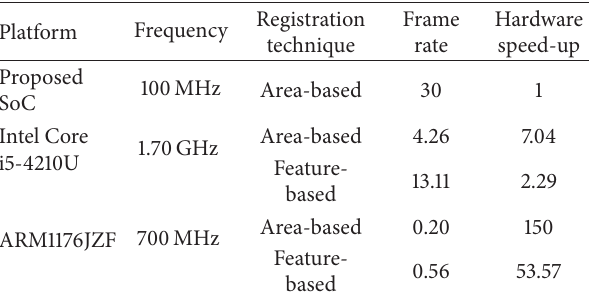
Table 5: Performance evaluation in terms of DR and FAR for 1000 frames using different density in ego-motion estimation, 𝑚 × 𝑛 , and frame differencing threshold, th fd .